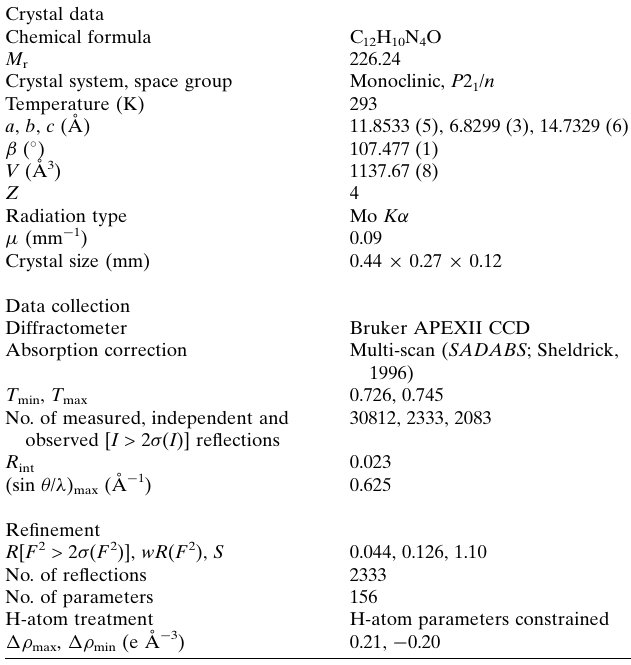
Table 5 Experimental details. Crystal data Chemical formula